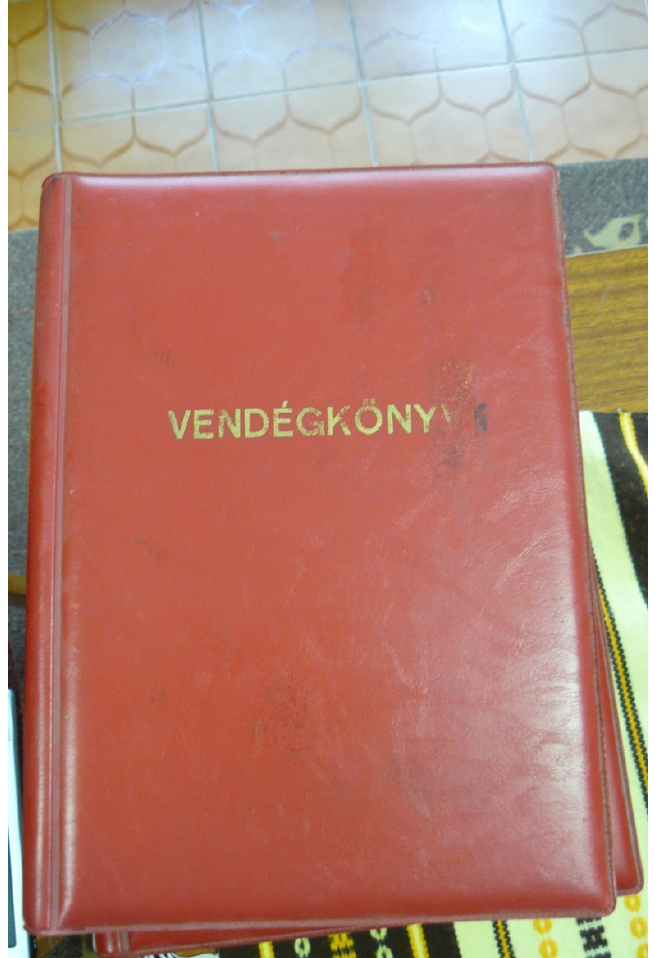
Figure 6. A Guestbook from the archive of Máriagy ű d, Photo taken by Krisztina Frauhammer, 2008.